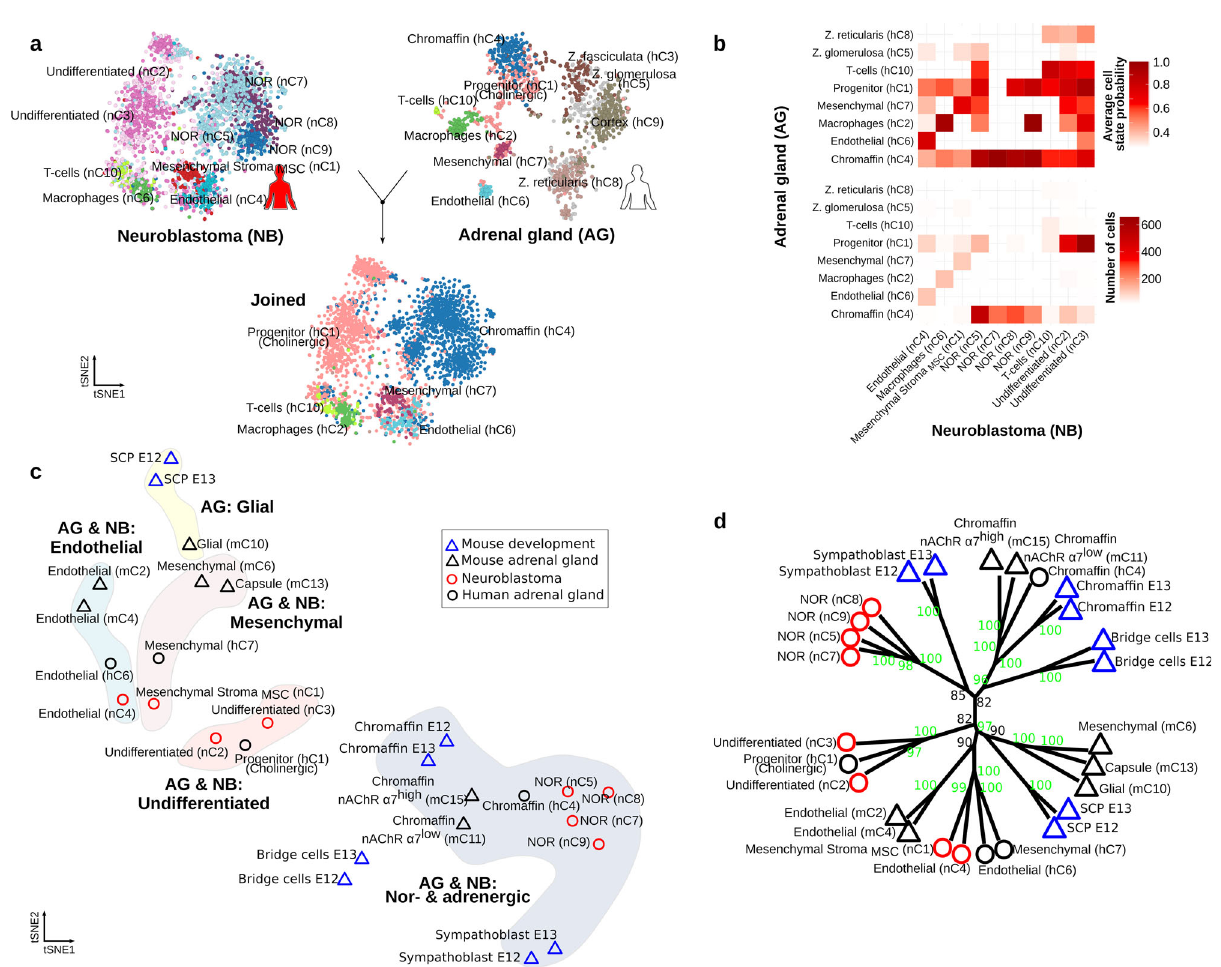
Fig. 7 Commonalities in the transcriptional pro fi le of cell populations in postnatal and developing human and mouse adrenal glands, and neuroblastoma. a tSNE illustrating the projection of postnatal human adrenal gland cell clusters (i.e., states, reference top right) onto neuroblastoma (query top left), based on the detection of mutual nearest neighbor cell anchors (as detailed in “ Methods ” ). Joint visualization of the neuroblastoma cell clustering (bottom) after cell classi fi cation with colors corresponding to the transferred adrenal gland cell states. b Heatmaps of the average probabilities of best matching reference states for each query cluster (i.e., average cell state probability, top), including number of cells (bottom). c tSNE using Euclidean distances in the quartile-normalized matrix of the average normalized expression from single-cell/nuclei sequenced cell populations from (A) human (i) neuroblastoma and (ii) adrenal gland, and (B) mouse (i) adrenal gland and (ii) derived adrenal anlagen at E12 and E13 6 . Mesenchymal, endothelial, and neural-crest derived populations from human and mouse, adrenal gland, and neuroblastoma group accordingly to gene expression in (i) adrenergic and noradrenergic cells, (ii) undifferentiated cells, (iii) mesenchymal, and (iv) endothelial cells. d Hierarchical clustering of transcriptional similarities between cell clusters supported with unbiased p -values 41 . Green numbers in the branches indicate a high support (i.e., unbiased p -value > 95) that has a lowest support at 0 and a highest at